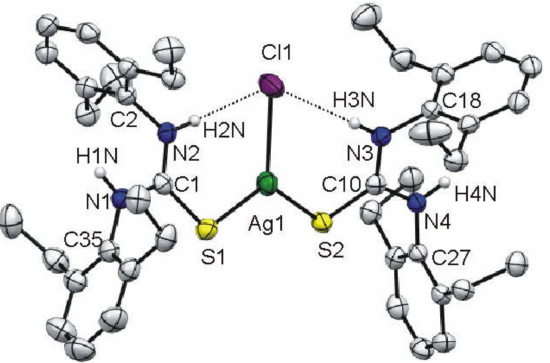
Figure 7. Molecular structure of 2a (ellipsoids correspond to the 50% probability level). Hydrogen atoms, except those of N-H, have been deleted for clarity. Selected bond lengths (Å) and angles ( ◦ ):